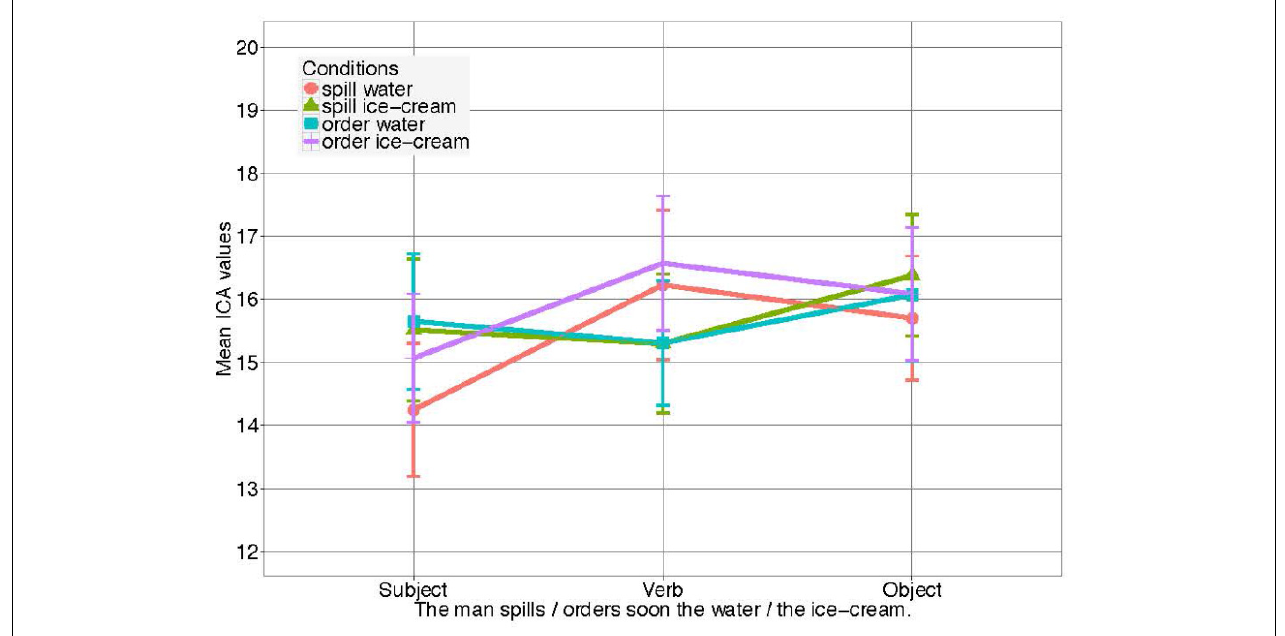
FIGURE 1 | ICA Results for Experiment 2 in all four conditions. Error bars reflect 95% confidence intervals (CI). For the models see Supplementary Materials